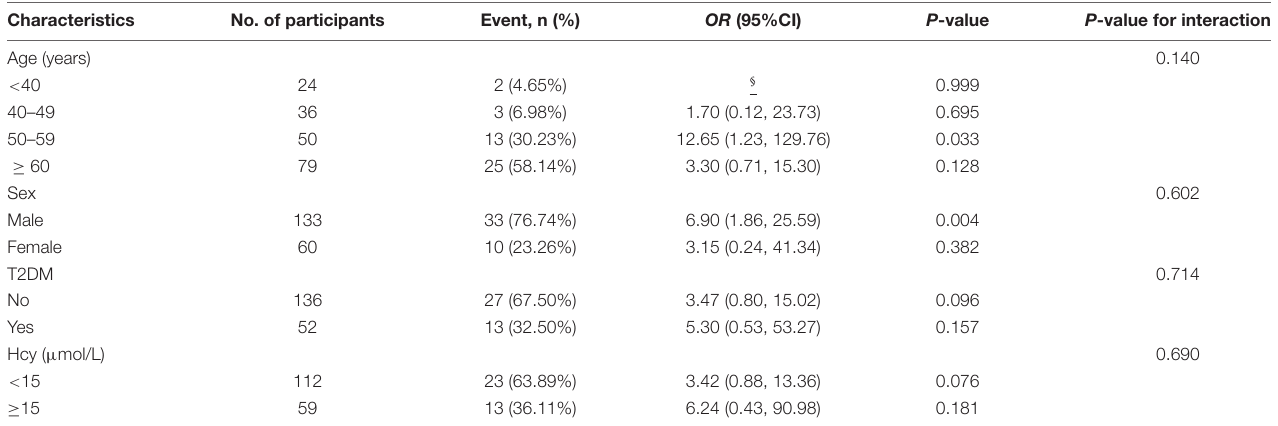
TABLE 5 | Odds ratios of hypertension on BA vulnerable plaque in the prespecified and exploratory subgroups.